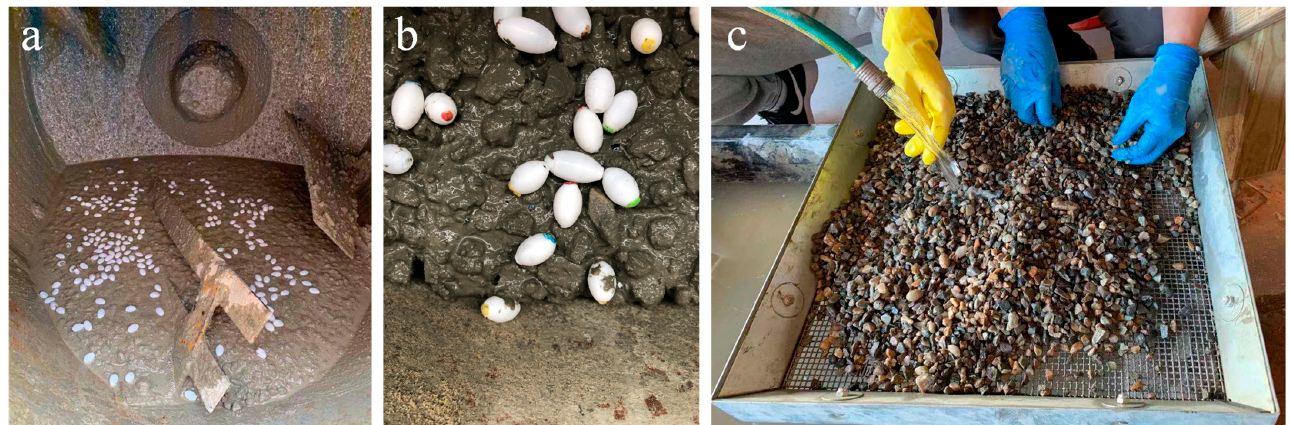
Figure 2. Survivability test procedure: ( a ) and ( b ) mixing, and ( c ) washing and capsule separation.